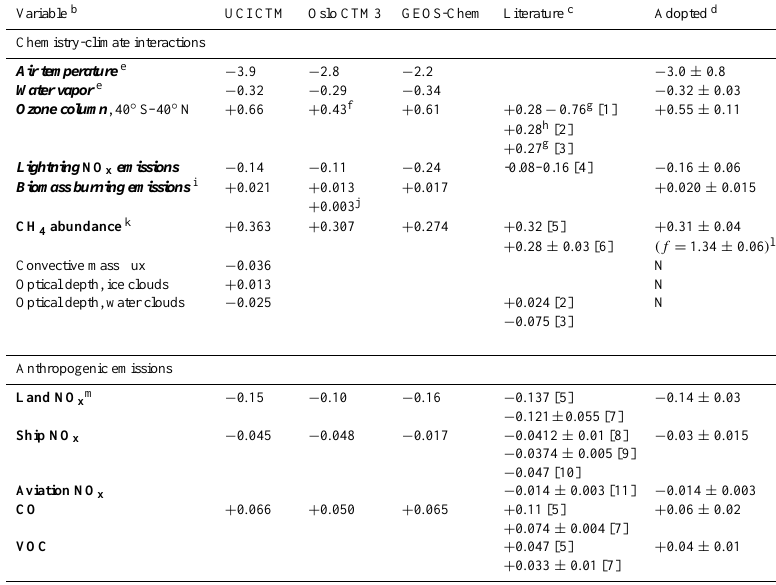
Table 2. Sensitivity of τ CH